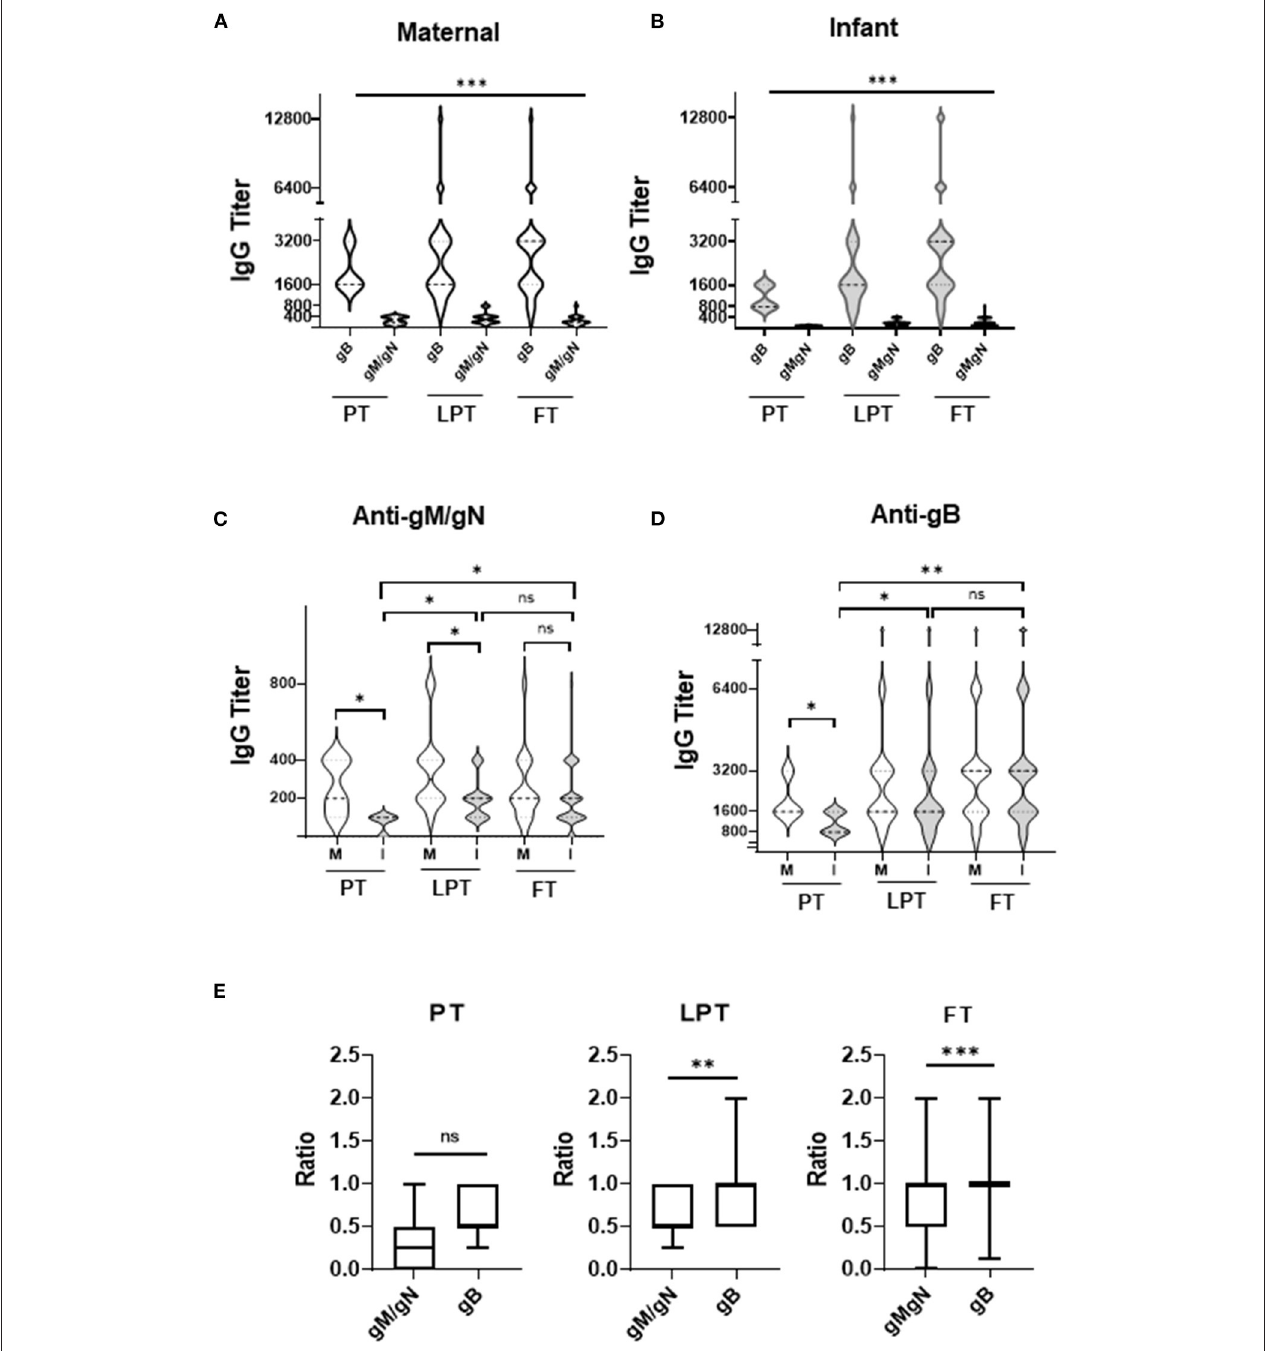
FIGURE 1 | Anti-gM/gN and anti-gB antibody titers among mother-infant dyads. (A,B) CMV anti-gM/gN antibodies and anti-gB antibodies were quantitated by ELISA for mothers (A) , and infants (B) . (C,D) Antibody titers against gM/gN (C) or gB (D) were compared for preterm (PT), late-preterm (LPT), and full-term (FT) mother (M) and infant (I) groups. (E) Transplacental transmission ratio between maternal 3 rd trimester and infant cord blood of anti-gB and anti-gM/gN antibody titers were calculated for all gestational ages (PT, LPT, FT). Data is shown as the median value with min-max ranges plotted. ns, not significant; * p < 0.05; ** p < 0.01; *** p < 0.001.